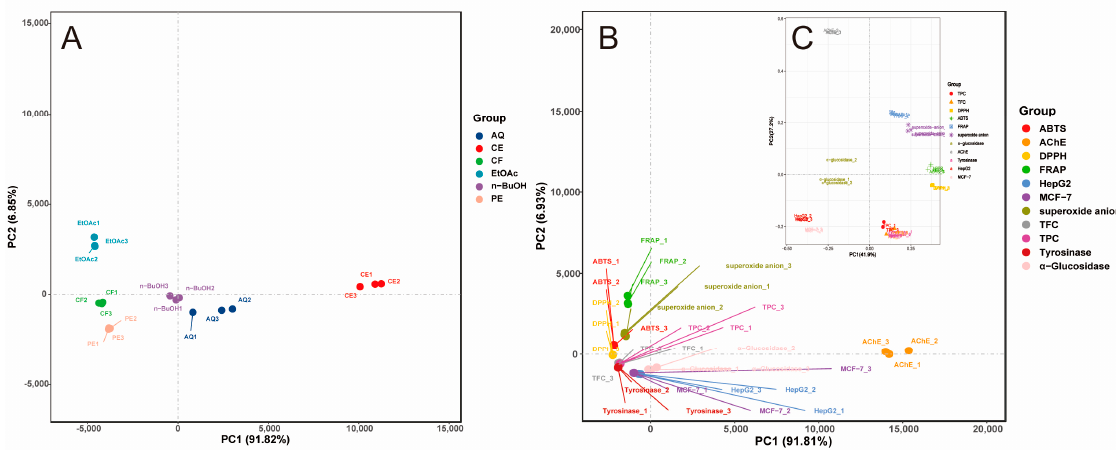
Figure 2. Principal component analysis (PCA) of different samples and indicators. ( A ) PCA of six P. frutescens leaf extract and fractions; ( B ) PCA of 11 indicators of active ingredient content and biological activity; ( C ) principal co-ordinates analysis (PCoA) of 11 indicators of active ingredient content and biological activity. CE = crude extract; PE = petroleum ether fraction; CF = chloroform fraction; EtOAc = ethyl acetate fraction; n-BuOH = n-butanol fraction; AQ = aqueous phase residue; TPC = total phenolic content; TFC = total flavonoid content; DPPH = DPPH · scavenging activity; ABTS = ABTS + scavenging ability; FRAP = ferric reducing antioxidant power; superoxide anion = superoxide anion scavenging activity; α - Glucosidase = the IC 50 value for α -glucosidase inhibitory; AChE = the IC 50 value for acetylcholinesterase inhibitory activity; Tyrosinase = the IC 50 value for tyrosinase inhibitory; HepG2 = the IC 50 value for inhibition on HepG2 cell proliferation; MCF-7 = the IC 50 value for inhibition on MCF-7 cell